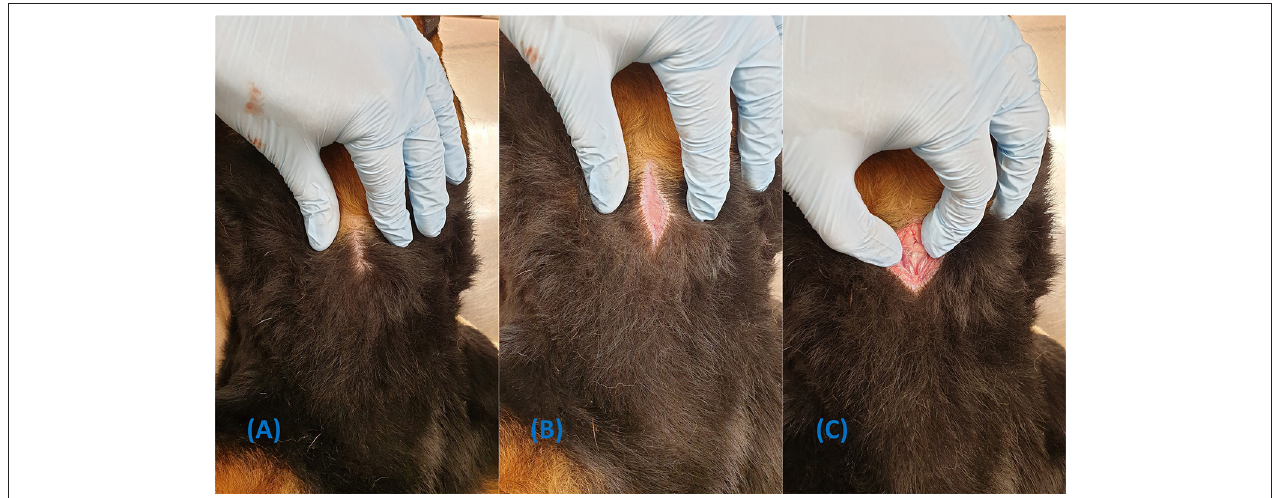
FIGURE 4 | Demonstration of how to perform a skin incision without clipping the fur. (A) Part the fur over the intended incision site. (B) Appy tension while the incision is made. (C) Dissection continues through the skin